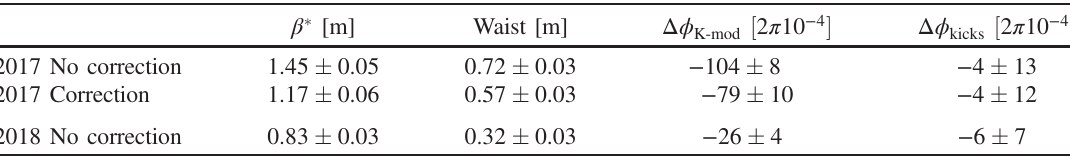
NEW LOCAL OPTICS MEASUREMENTS AND TABLE II. K-modulation measurements before (No correction) and after (Correction) of the β (cid:1) , waist and deviation from the model of the ϕ both from K-modulation [Eq. (3)] and from excited beam BPM recordings IP (kicks) at flat optics β (cid:1) ¼ 60 = 15 cm. The problem appeared in IP5 in the vertical plane in 2017 and in the horizontal plane of IP1 in 2018, both on Beam 1. The design β (cid:1) is 60 cm in the vertical plane of IP5 and the horizontal plane of IP1 (the flat plane is swapped in IP1 and IP5).